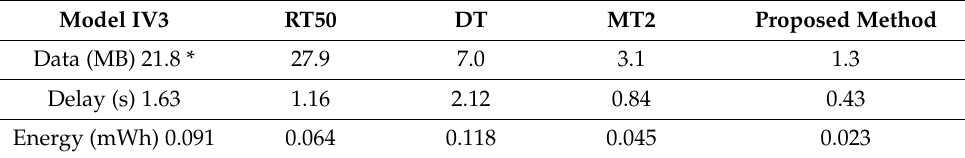
Table 6. Comparison of energy consumption and delay for different models.